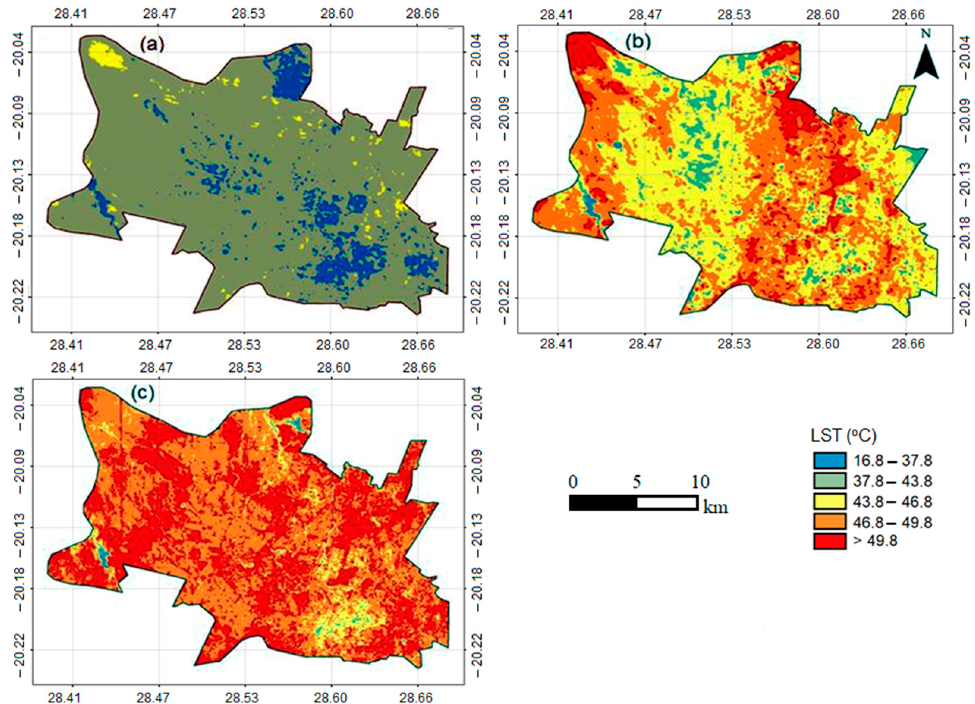
Figure 9. Spatial structure of LSTs in Bulawayo in ( a ) 1990, ( b ) 2005 and ( c ) 2020.